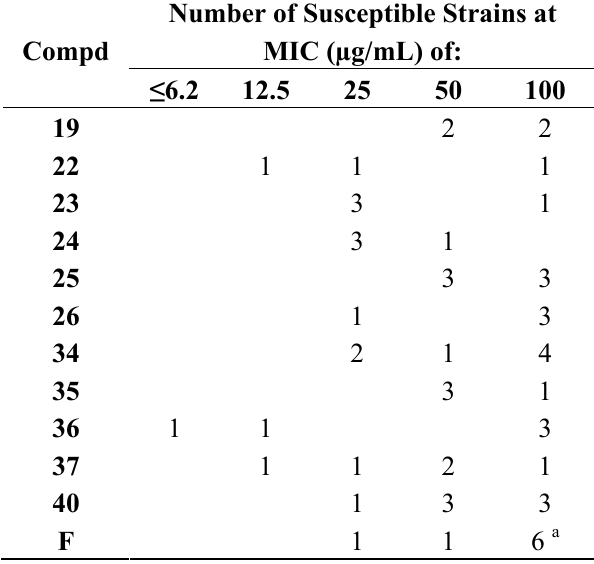
Table 2. Susceptibility of eight isolated strains of Candida albicans to the most active compounds. Number of Susceptible Strains at MIC (µg/mL) of: Compd ≤6.2 12.5 25 50 100 19 2 2 22 1 1 1 23 3 1 24 3 1 25 3 3 26 1 3 34 35 3 1 36 3